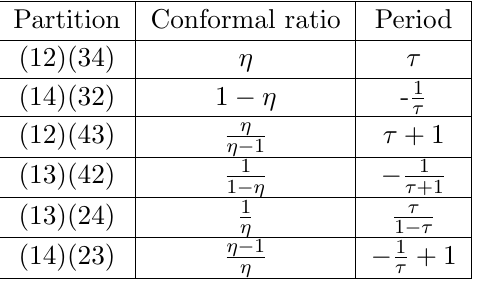
Table 1 . Partition of four points and modular